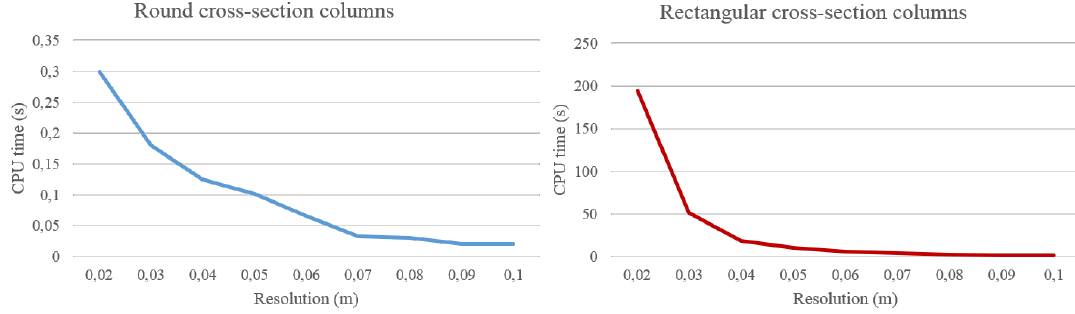
Figure 12. Computational effort is evaluated for different resolutions considering an area of 200 m 2 : round cross-section method ( left ), rectangular cross-section method ( right ).